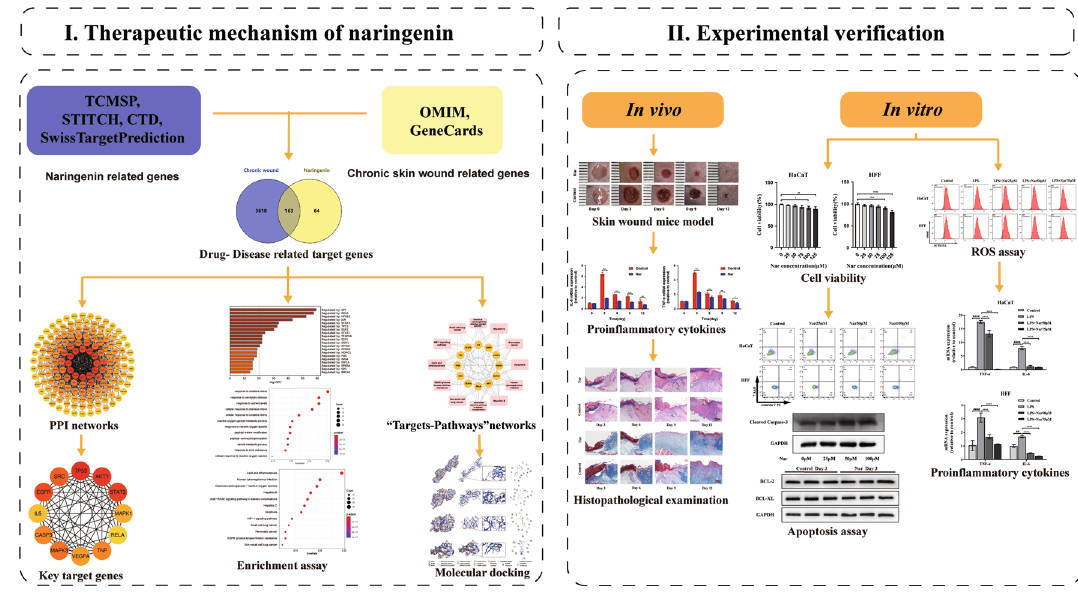
Figure 1. Workflow of the study.